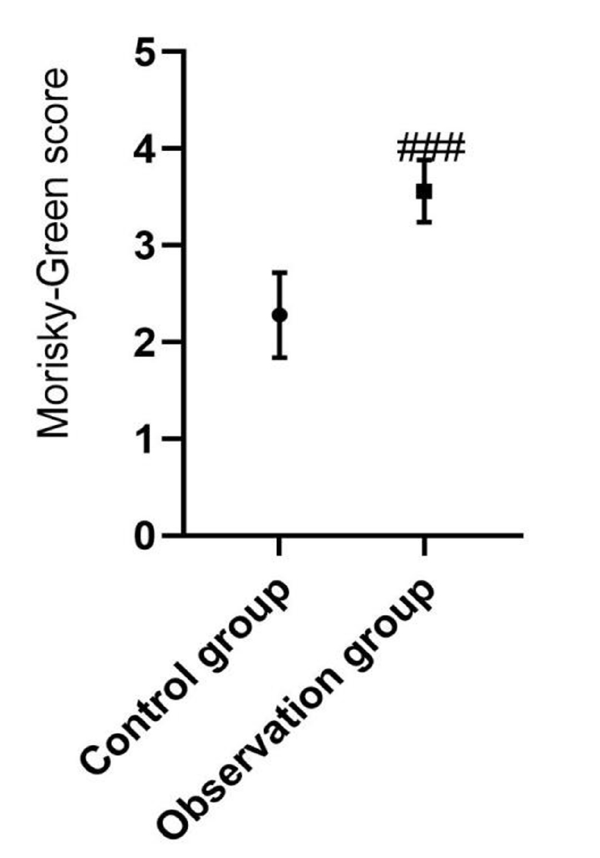
Fig. 1 - Comparison of Morisky-Green score between the two groups after continuing care. Compared with the control group after continuing care, ###